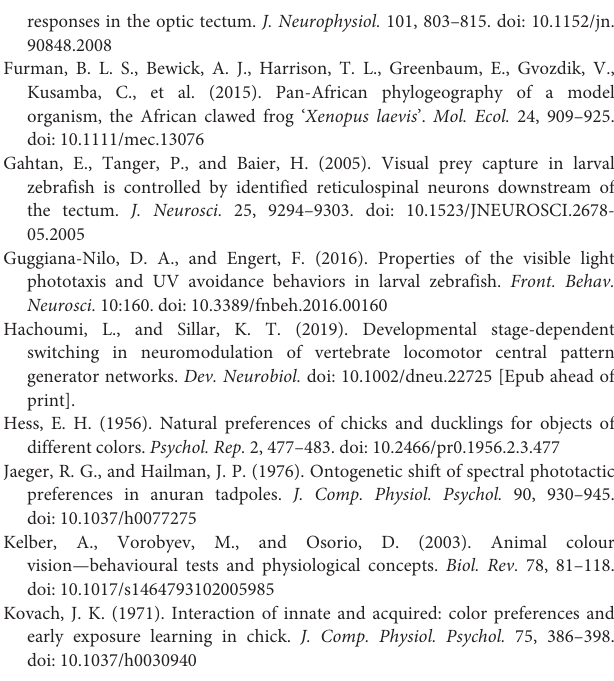
FIGURE S1 | The green preference is stable from 13-18 dpf. Each marker represents the average green preference for one 60-min